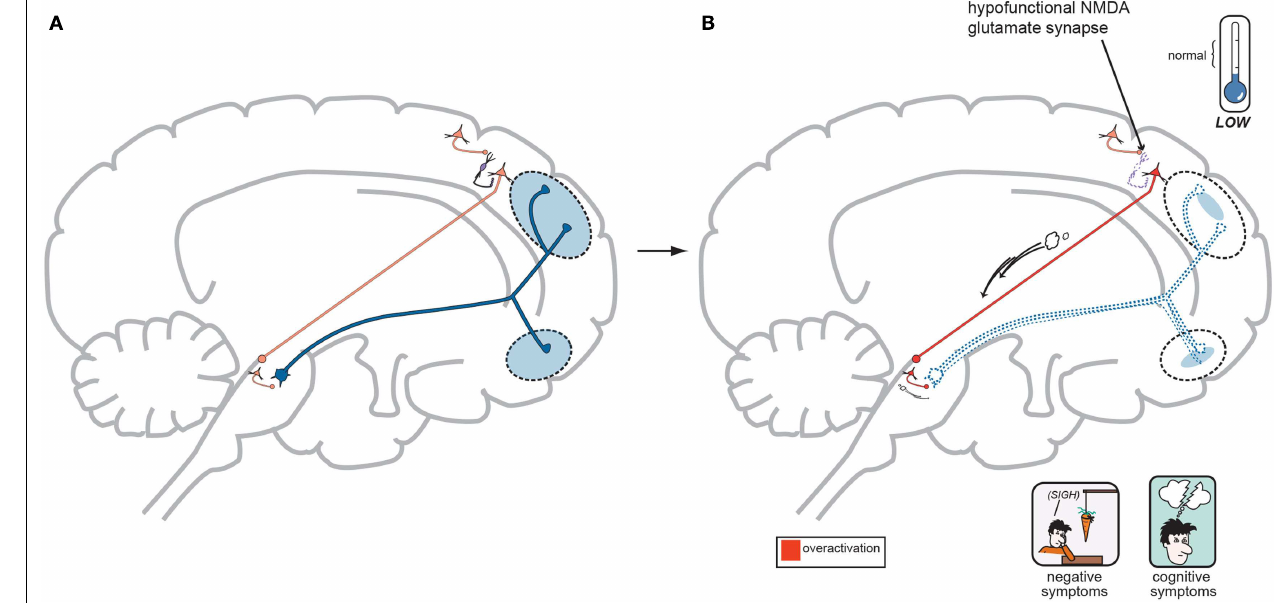
FIGURE 5 | (A) Normal GLU-GABA-GLU- GABA -DA Neuronal Circuitry and the NMDA Receptor Hypofunction Hypothesis for negative